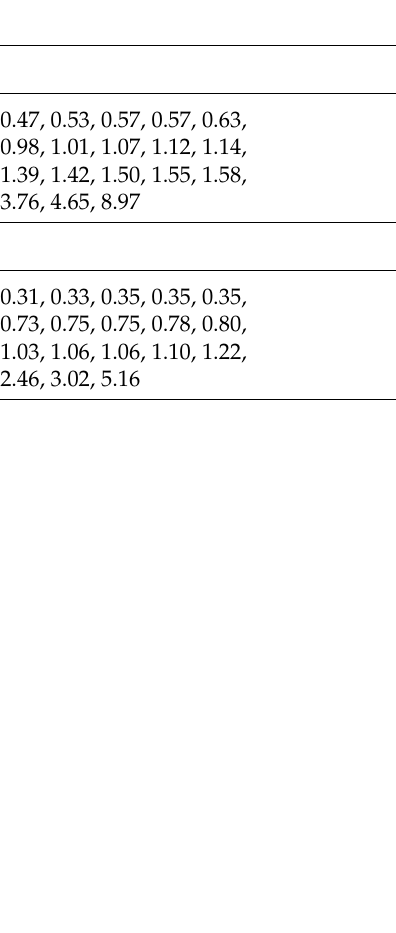
Figure 10. Fitted reliability ( left ) and PP ( right ) plots from LED